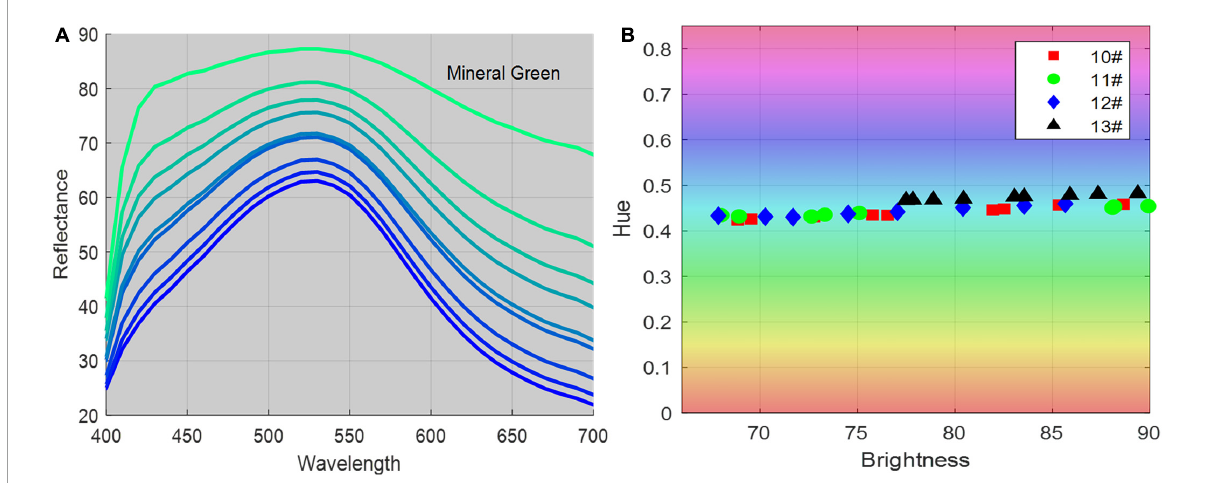
FIGURE4 Tint ladders of the mineral green pigment. (A) The spectral reflectance, (B) the chromaticity coordinates in the brightness-hue plane in HSV color